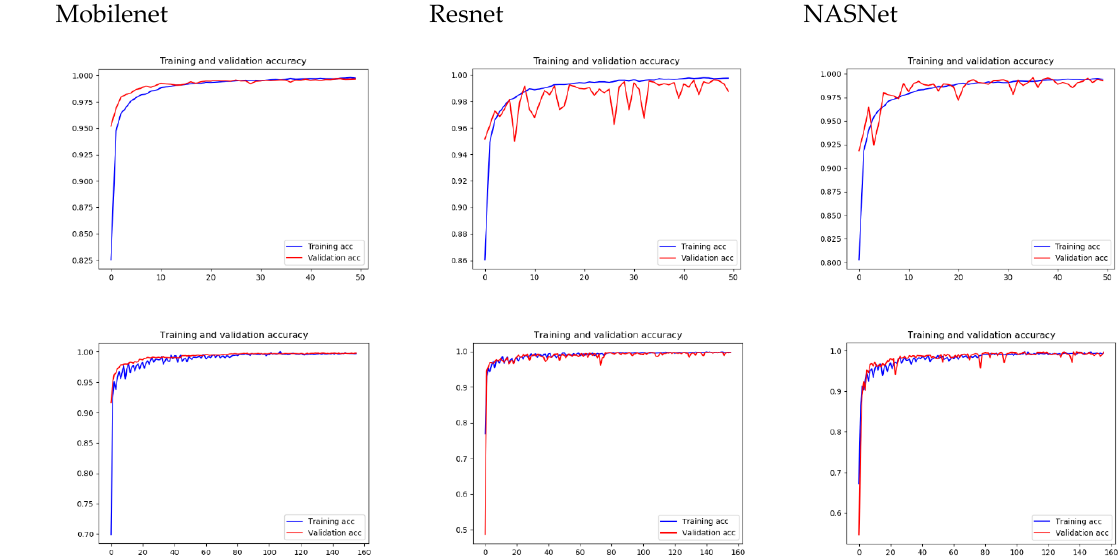
Figure 16. Precision, recall, and F1 score on each class in the large PlantVillage dataset. The blue bars indicate the ratio of the number of samples of a class to the maximum number of samples in all classes.